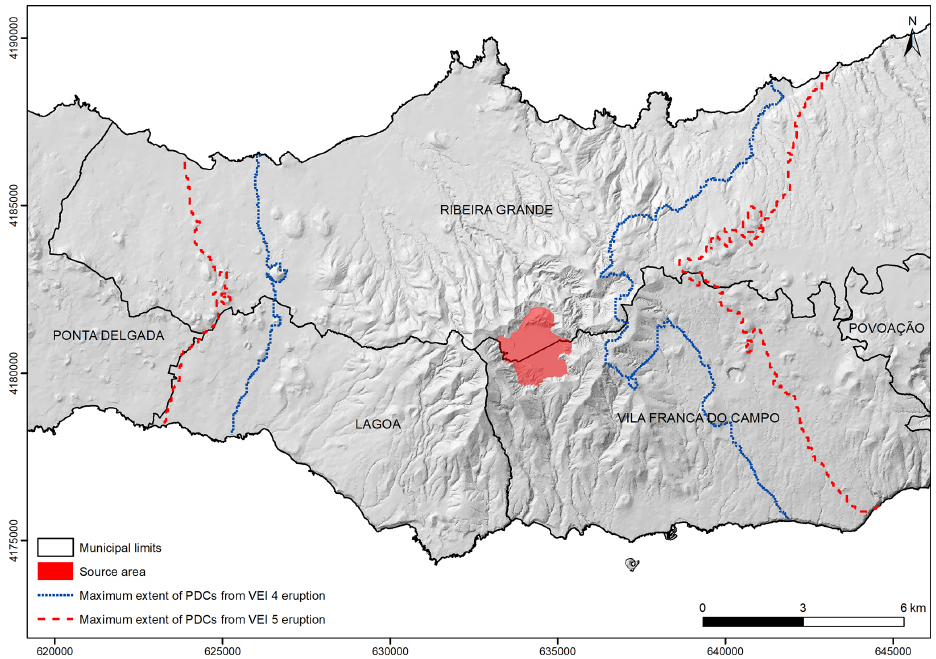
Figure 5. Maximum potential extent of PDCs from a VEI 4 sub-Plinian eruption (dotted blue line; collapse height of 300m) and from a VEI 5 Plinian eruption (dashed red line; collapse height of 500m) of Fogo volcano. UTM coordinates, zone 26S, datum WGS 84.